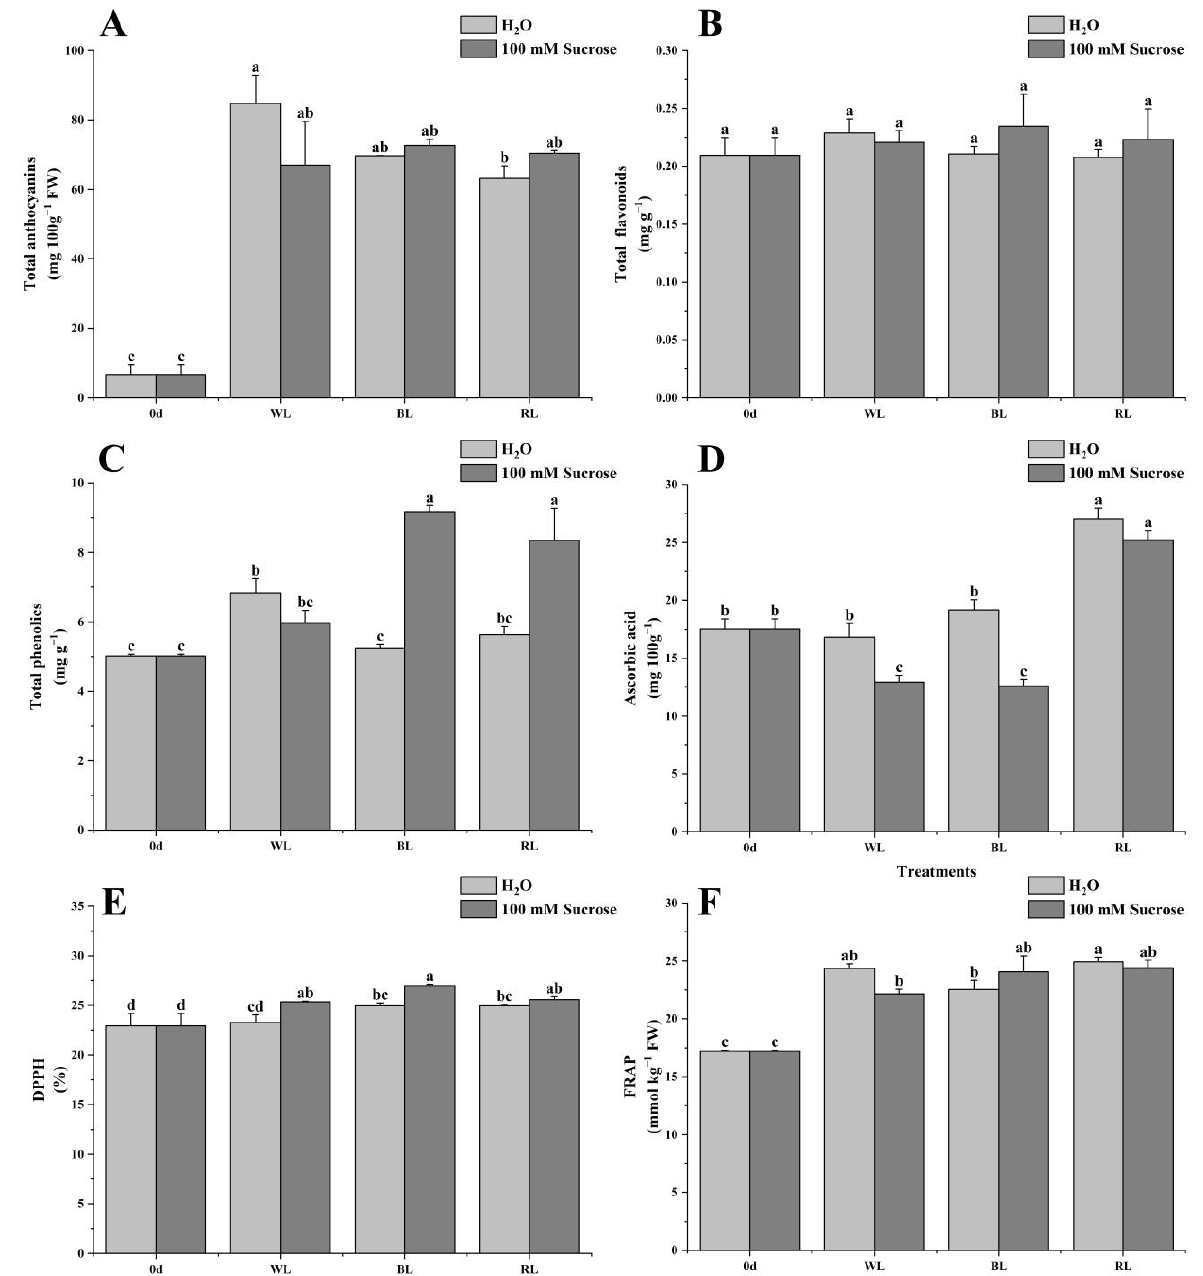
Figure 3. Effect of light quality and sucrose on total anthocyanins ( A ), flavonoids ( B ), phenolics ( C ), ascorbic acid ( D ), DPPH ( E ), and FRAP ( F ). Data represent the means ± standard error ( n = 3). Different lowercase letters indicate the statistically significant difference of the mean values based on one-way analysis of variance (ANOVA) followed by Duncan’s multiple range test ( p ≤